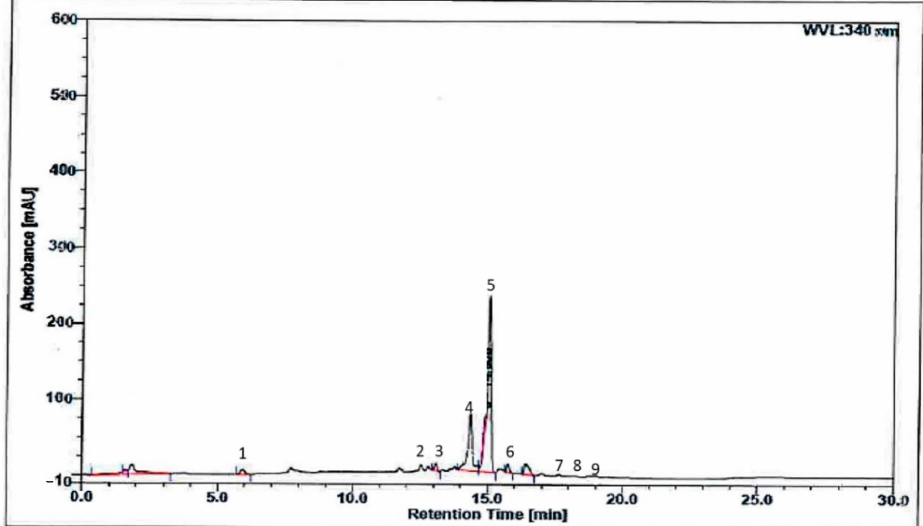
Figure 4. High-performance liquid chromatography analysis of BBE at 340 nm. Peak 1: gallic